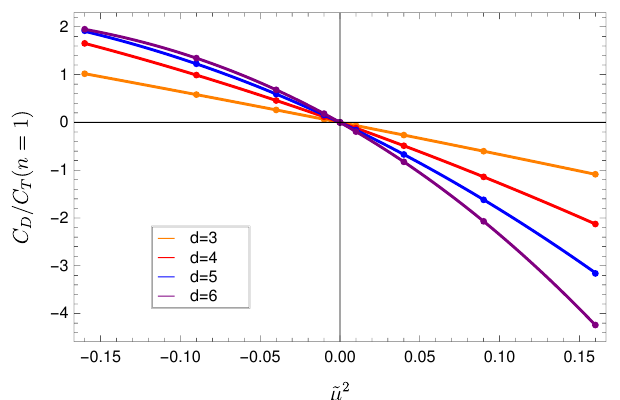
Figure 5 . C D /C T ( n = 1) as a function of the chemical potential ˜ µ 2 in eq. (3.37) for different spacetime dimensions. We set ‘ = 1 . The dots correspond to numerical results; the solid curves ∗ /L correspond to the analytic expansions determined in eqs. (3.38), (3.45), (D.8) and (D.10). The plot contains both real and imaginary chemical potentials such that ˜ µ 2 = ± 0 . 16 , ± 0 . 09 , ± 0 . 04 , ± 0 . 01 , 0